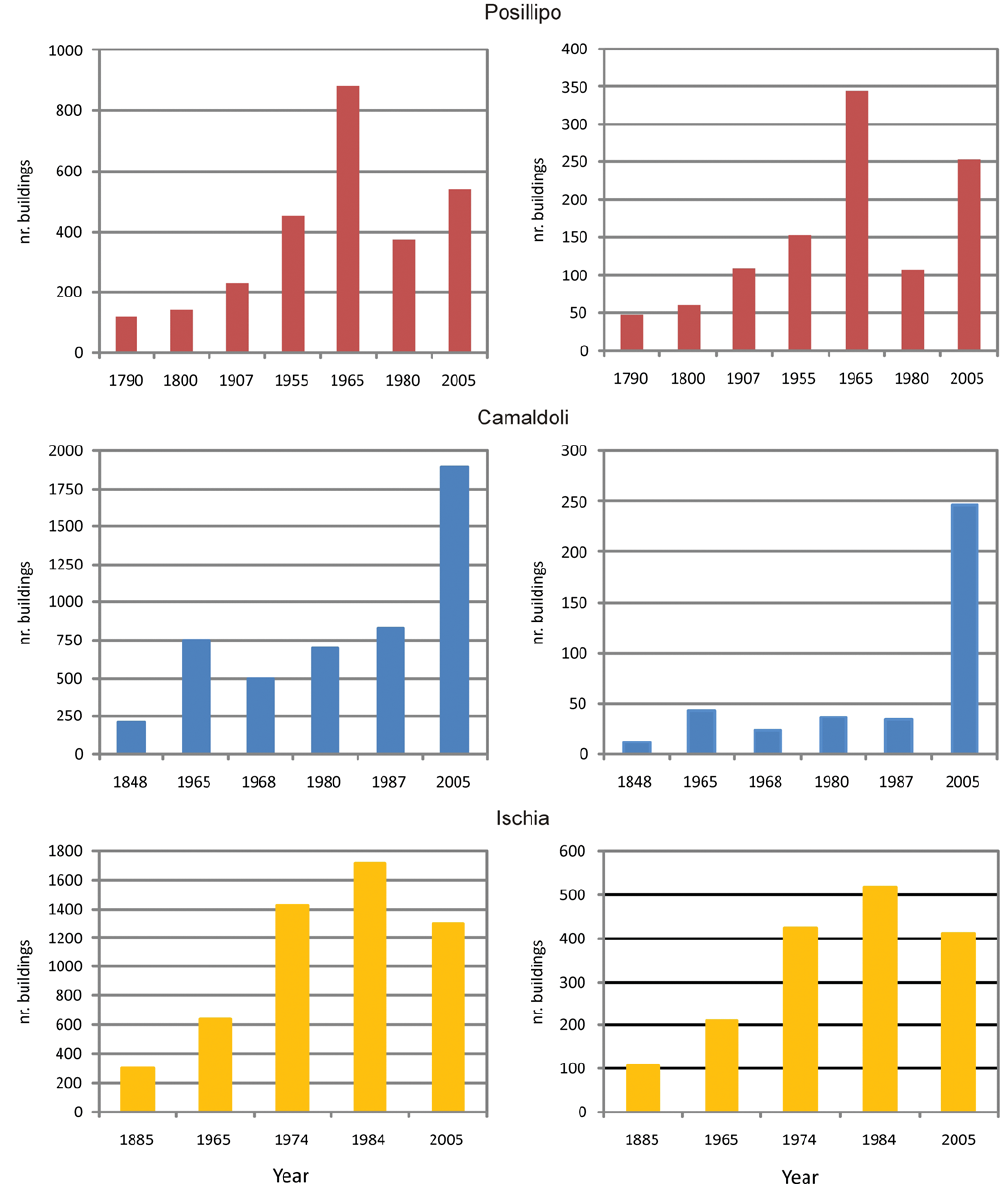
Fig. 20. Temporal distribution of buildings realised in the whole study areas (left) and in at-risk zones